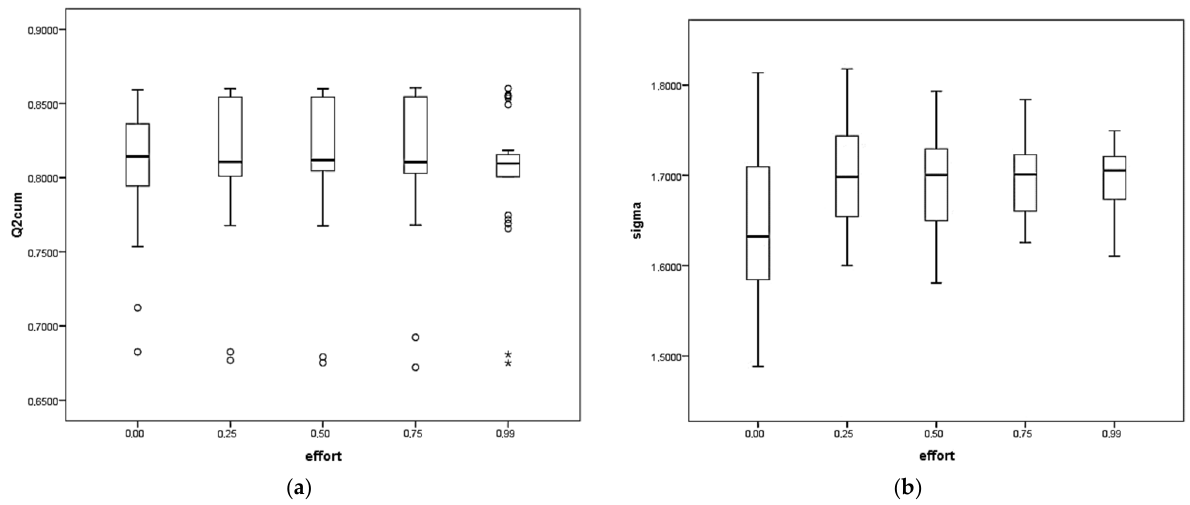
Figure 2. ( a ) Estimates of Q 2 cum for different values of the parameter effort ; ( b ) Estimates of σ for different values of the parameter effort